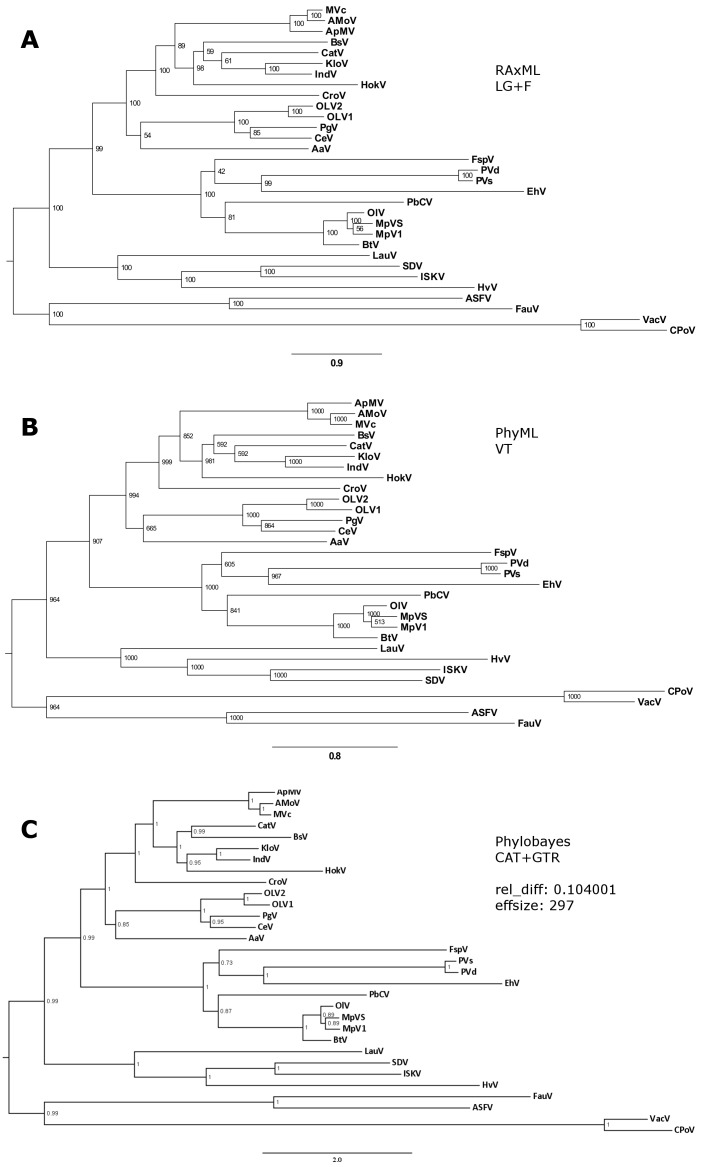
Phylogenetic analysis of five concatenated NCVOGs from selected NCLDVs.(A) Maximum likelihood phylogenetic tree based on 1000 bootstrap replicates as calculated by RAxML (B) Maximum likelihood phylogenetic tree based on 1000 bootstrap replicates as calculated by PhyML. (C) Bayesian posterior consensus tree with Bayesian posterior probability on two independent MCMC chains (16100 generations) MVc: Megavirus chilensis, AMoV: Acanthamoeba polyphaga Moumouvirus, ApMV: Acanthamoeba polyphage Mimivirus, CatV: Catovirus, BsV: Bodo saltans virus, HokV: Hokovirus, KloV: Klosneuvirus (KlosnV), IndV: Indivirus, CroV: Cafeteria roenbergensis virus, OLV1: Organic Lake Phycodnavirus 1, OLV2: Organic Lake Phycodnavirus 2, CeV: Chrysochromulina Ericina Virus, PgV: Phaeocystis globosa virus PgV-16T, AaV: Aureococcus anophagefferens virus, FspV: Feldmannia species virus, PVd: Pandoravirus dulcis, PVs: Pandoravirus salinus, EhV: Emiliania huxleyi virus 86, PbCV: Paramecium bursaria chlorella virus 1, OlV: Ostreococcus lucimarinus virus 1, MpVS: Micromoas pusillae Virus SP-1, MpV1: Micromoas sp. RCC1109 Virus, BtV: Bathycoccus sp. RCC1105 Virus, LauV: Lausannevirus, ISKV: Infectious spleen and kidney necrosis virus, HvV: Heliothis virescens ascovirus 3e, FauV: Faustovirus E12, ASFV: African swine fever virus BA71V, VacV: Vaccinia virus, CPoV: Canary pox virus.